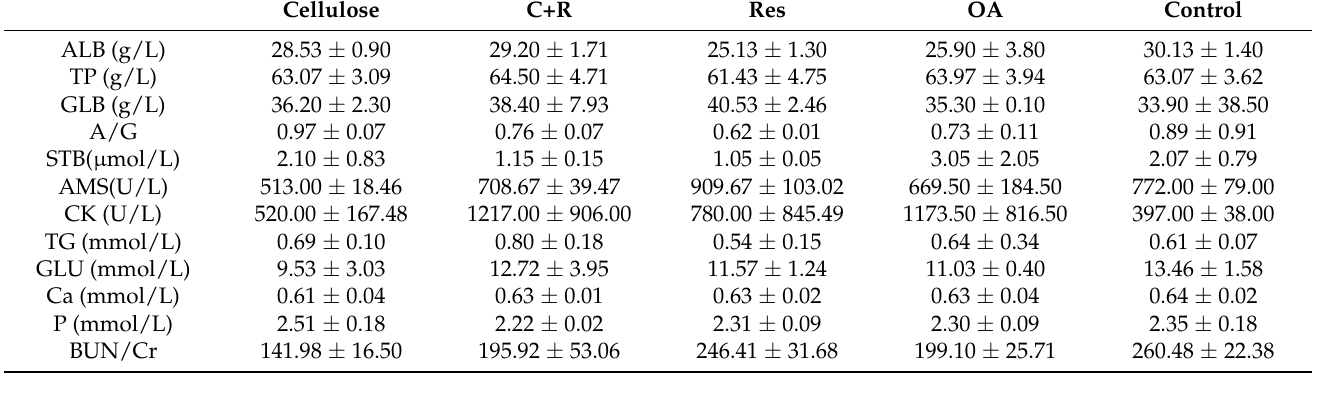
Table 1. Blood biochemical indexes of rats in each group.